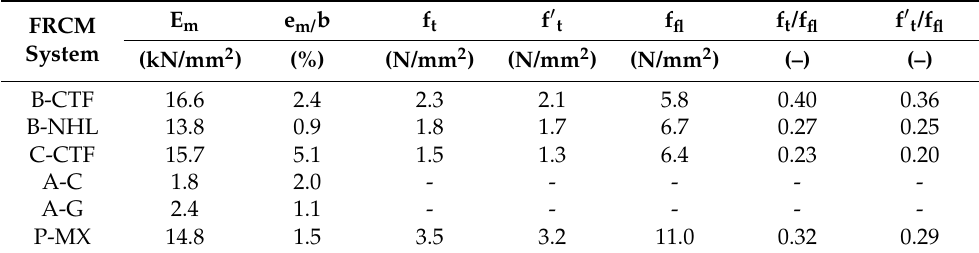
Table 12. Computed matrix